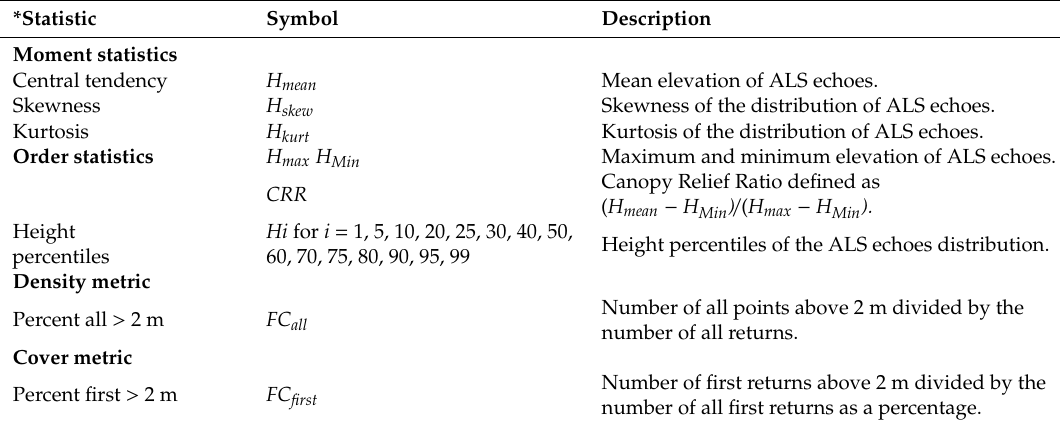
Figure 3. Implemented workflow based on Lastools software [38] to process the ALS data and conduct forest inventory using airborne laser scanning (ALS) under the area-based approach (ABA). Table 3. Set of statistics derived from airborne laser scanning data used as candidate predictor variables to build the estimation